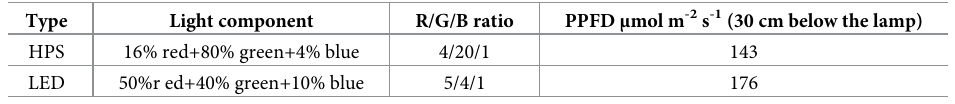
Chlorophyll fluorescence and chlorophyll fluorescence induction kinetic (OJIP) curve parameter measurements. Chlorophyll fluorescence was analyzed with Handy PEA (Hansa- tech Instruments, Ltd., Norfolk, UK). For each experimental treatment, the first leaves above the first truss fruit from 10 random plants were measured at the same position and then aver- aged. The first measurement was performed after most leaves had just completely unfolded and was recorded as the measurement for the 1 st day, and then the measurements were repeated on the 10 th day, 20 th day, 40 th day, and 60 th day. Before the measurements, the leaflets were clamped into the leaf chamber of the instrument to adapt to the dark for 30 minutes. The intensity of chlorophyll fluorescence was recorded in arbitrary units. Those were trans- formed into units of the relative variable chlorophyll fluorescence (V ) via double t Table 1. Light quality of the two types of lamps